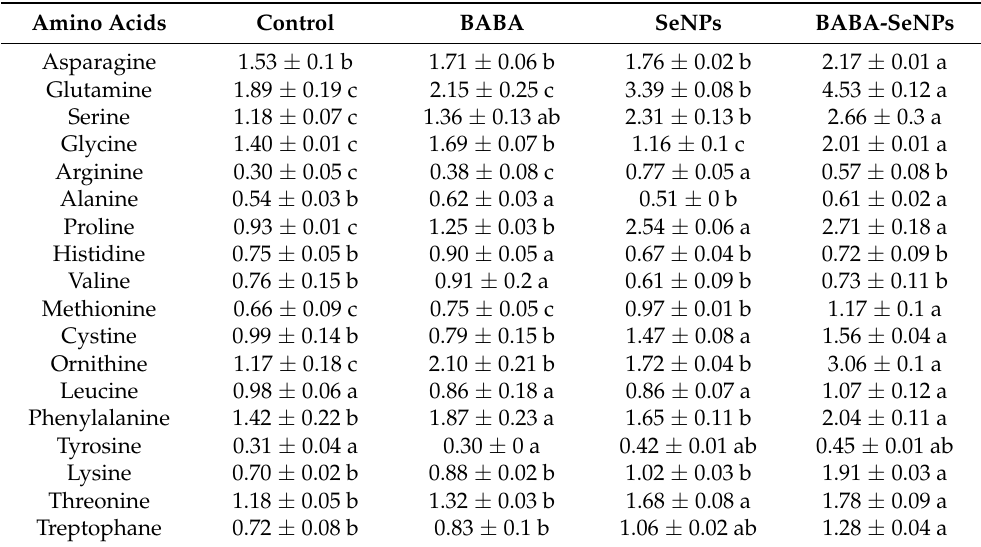
Table 3. Amino acids ( µ g g − 1 FW) of control and BABA- and/or SeNPs-treated M. interexta sprouts. Data are represented by the means of four replicates ± standard